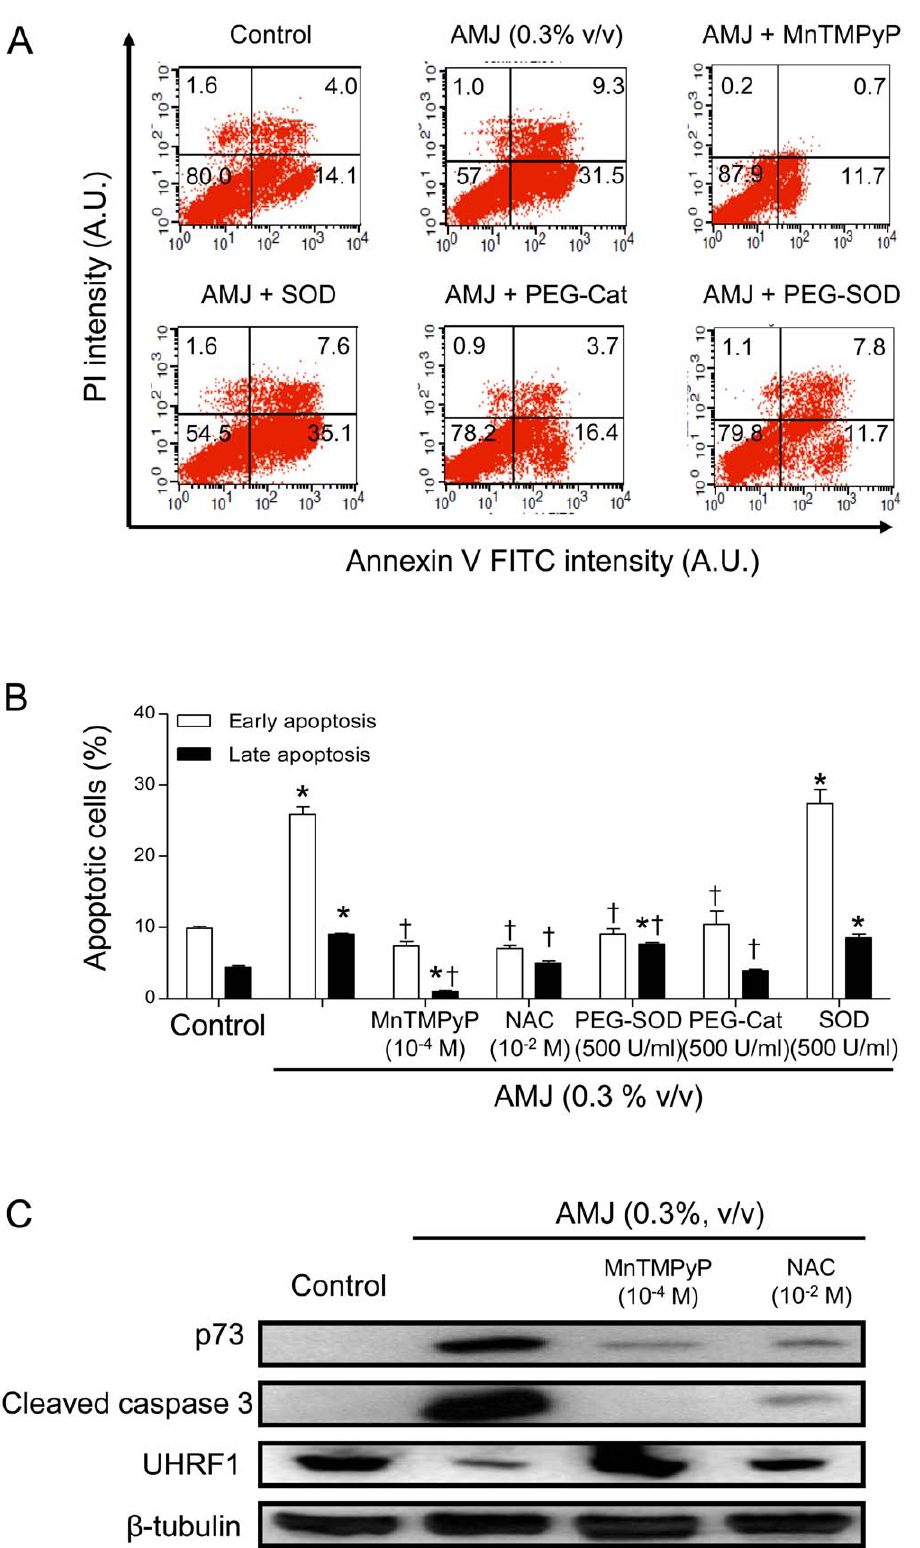
Figure 4. AMJ induced a ROS-dependent pro-apoptotic effect in Jurkat cells. Cells were exposed to antioxidant treatment as indicated 30 min before the addition of AMJ for 24 h. (A) and (B) cell apoptosis rates were assessed by flow cytometry using the annexin V-FITC/PI apoptosis assay. (A) Illustrates representative cell sorting results for the indicated treatments. (B) shows cumulative data of cells in early or late stages of apoptosis. Values are shown as means 6 S.E.M. (n=3); *, P , 0.05 versus respective control; { , P , 0.05 versus respective AMJ-treated cells. (C) The expression level of p73, active caspase 3 and UHRF1 was assessed by Western blot analysis. Similar findings were observed in three independent experiments. doi:10.1371/journal.pone.0032526.g004 PLoS ONE |